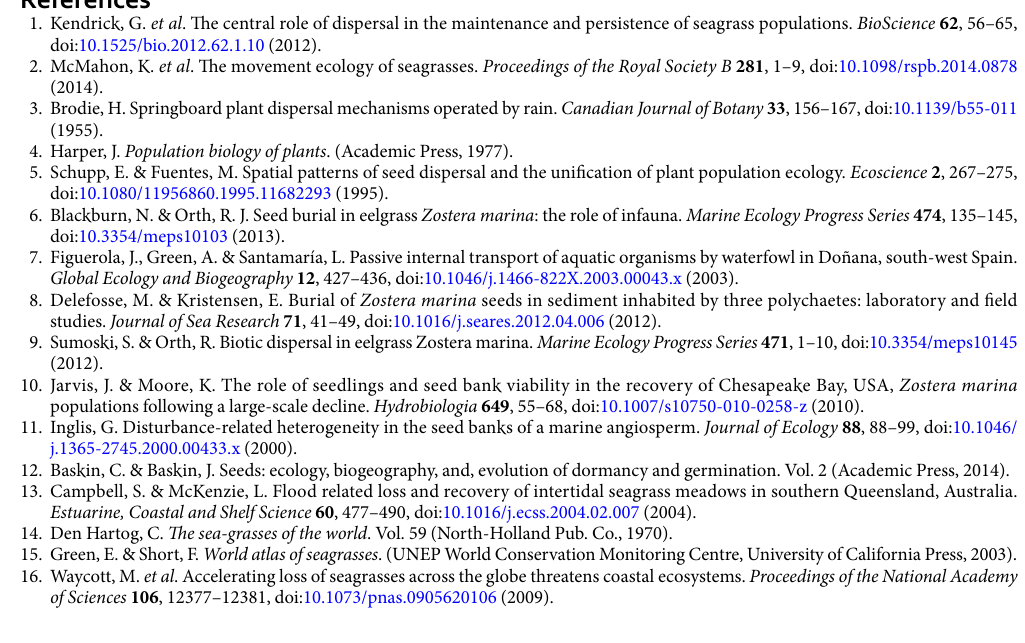
counted prior to the removal of the seed coat. Once the seed coat was removed, all non-germinated seeds were stained with a 0.5% Tetrazolium solution for a total of 48 hours to determine viability 44 . A positive stain (tissue turns brown to red in colour; Fig. 5a) indicated normal cellular metabolism within cells, signifying that the seed was still active and capable of germination 44, 61 . Any seeds removed from the faeces that had already germinated were counted as viable (Fig. 5b). Seeds with a split seed coat were also counted per sample. Faecal matter was dried at 220 °C in an oven until a consistent dry weight was reached. Samples were then weighed and reported as g DW. Due to the low number of seeds collected per sample, seed data was combined across seagrass species and reported as the total number of seagrass seeds per g DW of faecal matter, the proportion of seeds with a split seed coat per g DW of faecal matter and the proportion of viable seagrass seeds per g DW of faecal matter (Fig. 2). Statistical analyses were conducted in the statistical software environment R (R version 3.2.5) 62 . Differences in the abundance of seagrass seeds per g DW of facecal matter over time (month) and site were analysed using gener- alized linear mixed effects models with a quasi-Poisson distribution (GLM) 62 ; a Tukey post hoc test was applied. Quasi-Poisson regression is a generalized form of Poisson regression which corrects for overdispersion in count data 63 . Changes over time (month) and site in the proportion of seeds with a split seed coat and the proportions of seeds that stained as viable (positive stain + germinated seeds) per g DW of faecal matter were analyzed using logistic regression mixed effects models with a binomial distribution (GLM) 62 ; a Tukey post hoc test was applied. Logistic regression was selected due to the binary response variable and the small number of seeds found per sample 64 .